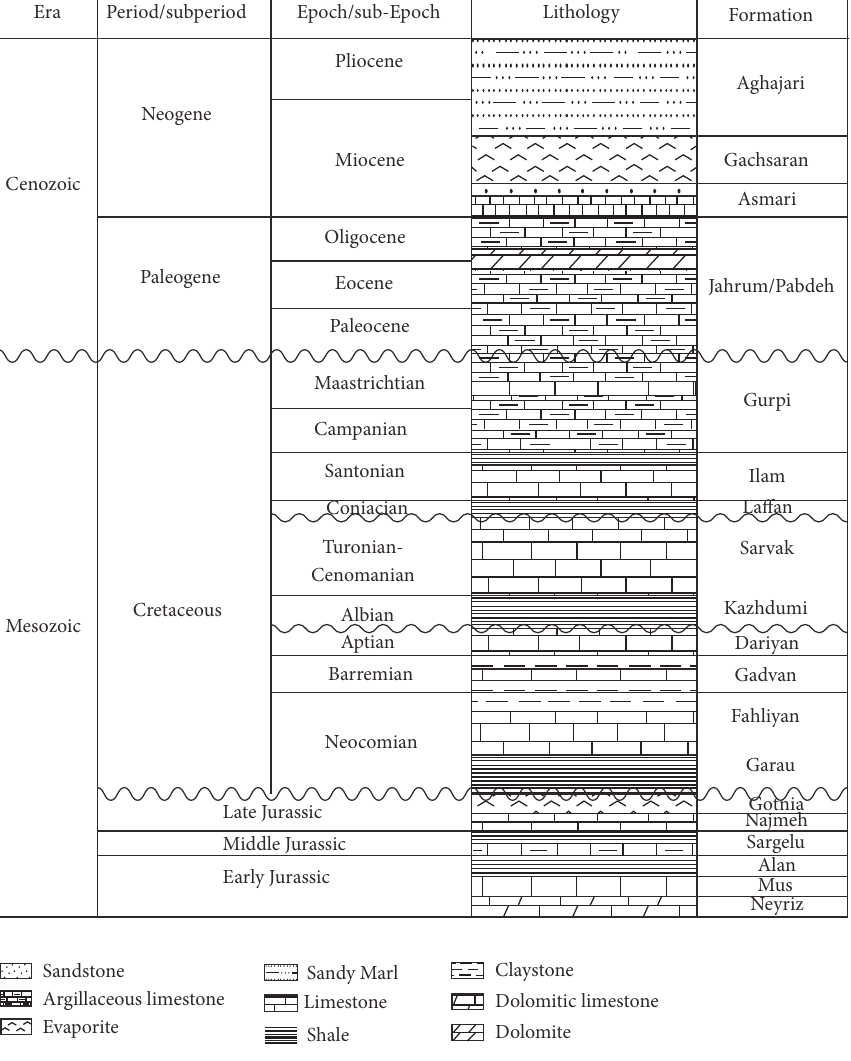
Figure 2: The general penetrated stratigraphic column in the Abadan Plain Basin (no vertical